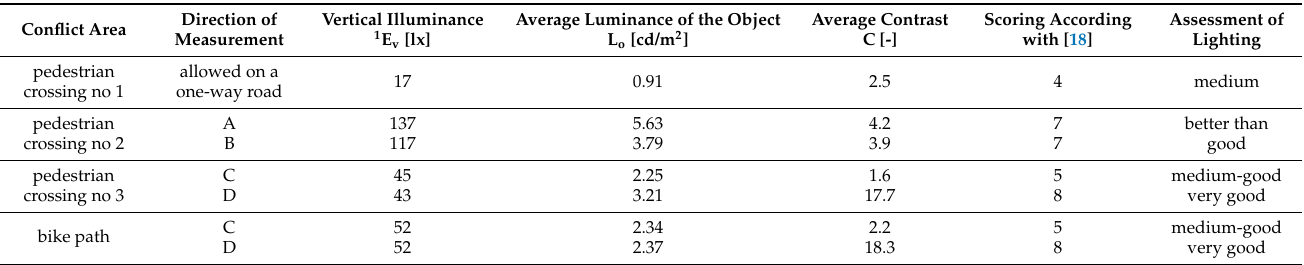
Table 7. Scoring and evaluation of the quality of pedestrian silhouette illumination at tested